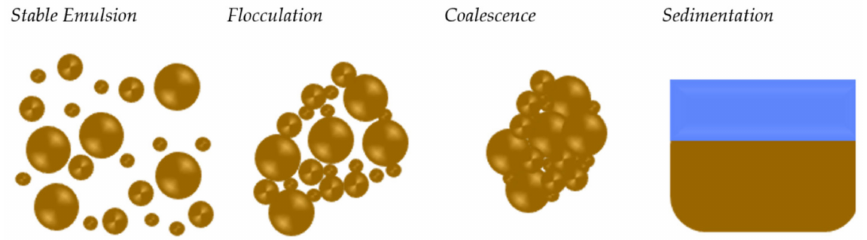
Figure 4. Bitumen emulsion flocculation, coalescence, and sedimentation adapted from